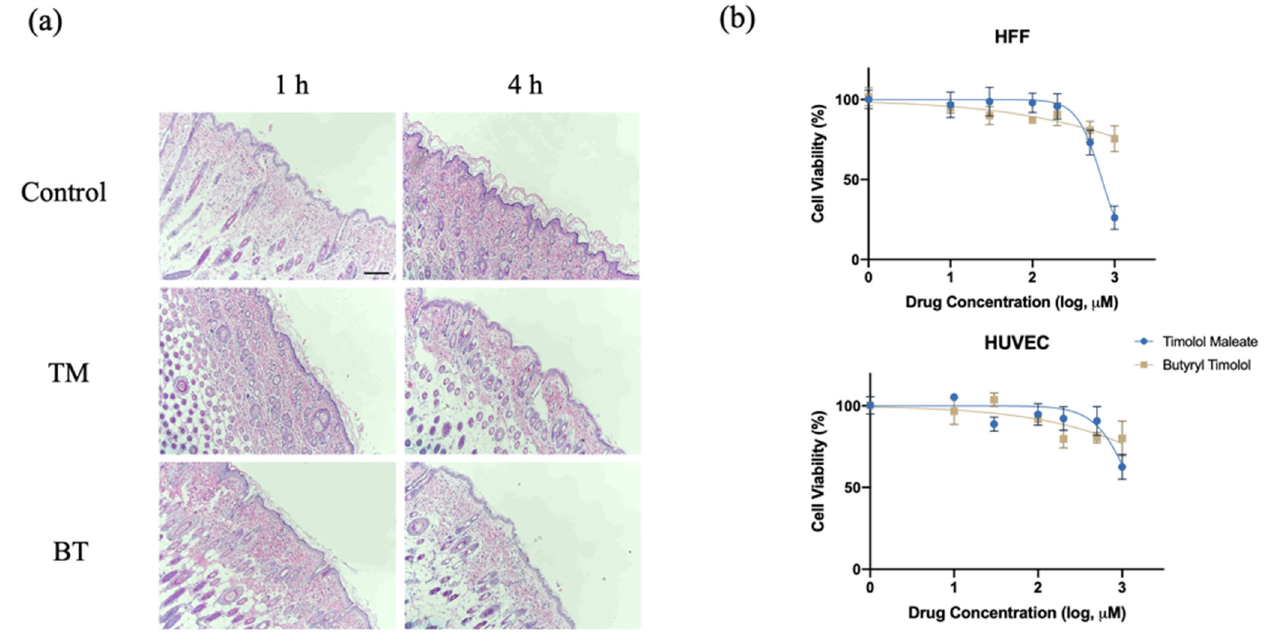
Figure 2. In vitro and in vivo toxicity evaluation of BT. ( a ) Histological examination of nude mouse dorsal skin stained with hematoxylin and eosin with no treatment (control), topical TM, and topical BT application for 1 and 4 h. Scale bar = 250 µ m; ( b ) Cytotoxicity of TM and BT on normal human umbilical vein endothelial cells (HUVEC) and human foreskin fibroblasts (HFF) assessed by CCK8 assay. Values represent the mean ± SD (n = 3).